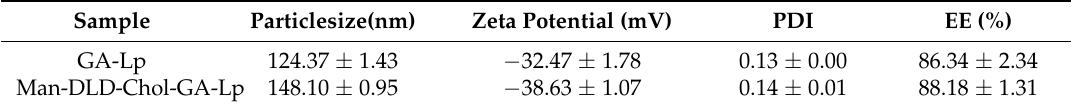
Table 1. The characterizations of the liposomes (mean ± SD, n = 3).